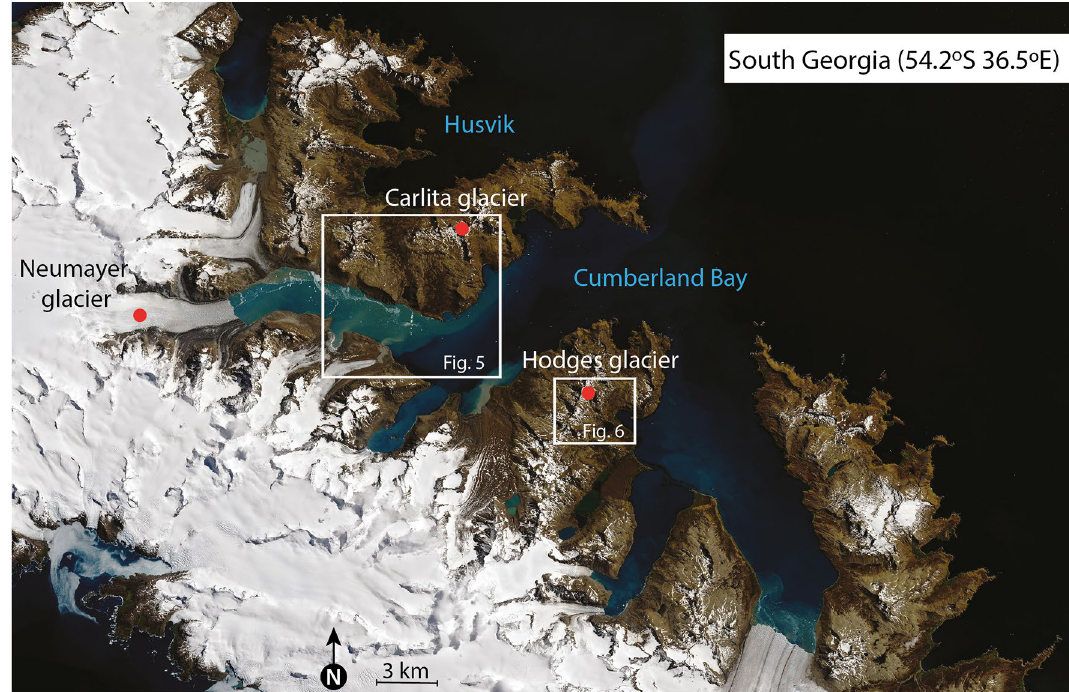
Figure 2. The island of South Georgia (54°S, 36°W) is 170 km long and ranges from 2 to 40 km wide; it is surrounded by a shallow shelf area with an average depth of 250 m. Glaciers and alpine mountains completely cover the central parts of the island, whereas the Cumberland Bay area is less glaciated, even though the landscape is clearly shaped by erosive glaciers, which is exemplified by the numerous cirques, u-shaped valleys, fjords, and lakes (The figure was created in Adobe Illustrator 2021 using data from NASA Worldview).